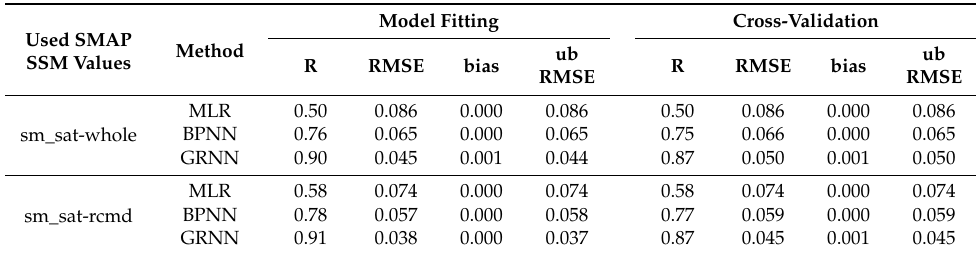
Table 2. Performance of the proposed GRNN model compared with MLR and